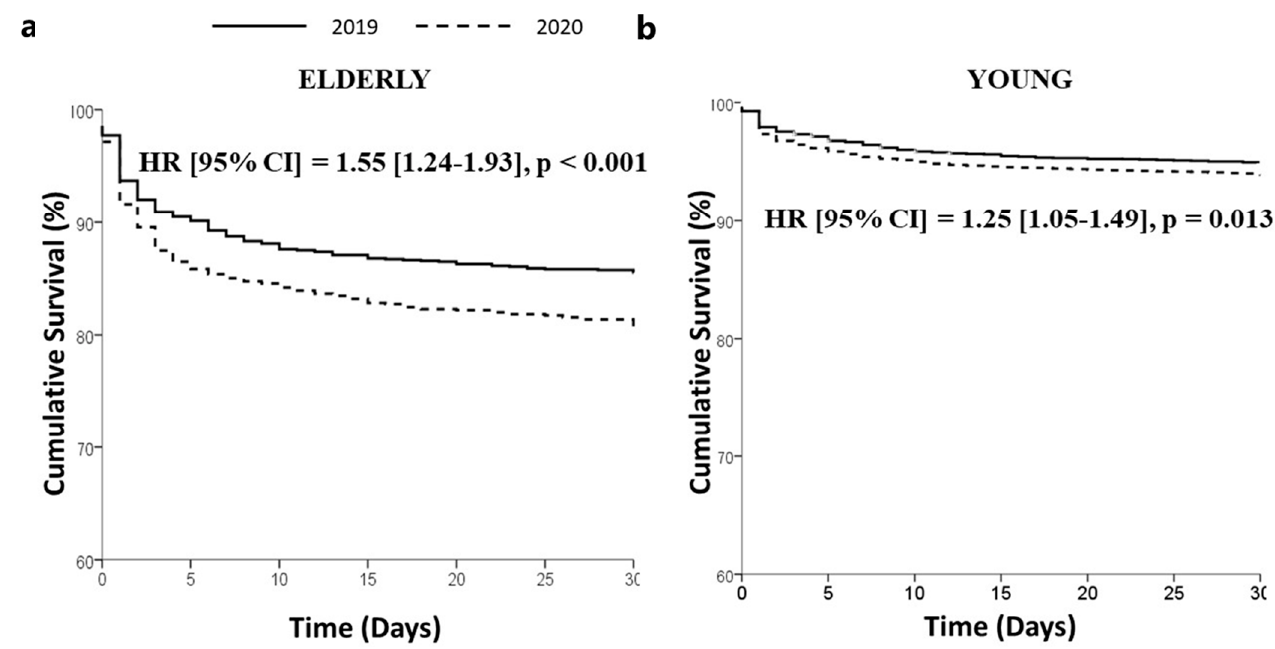
Figure 3. Kaplan–Meier survival curves of STEMI patients treated in 2019 and 2020 among elderly ( a ), left graph) and young patients ( b ), right graph).